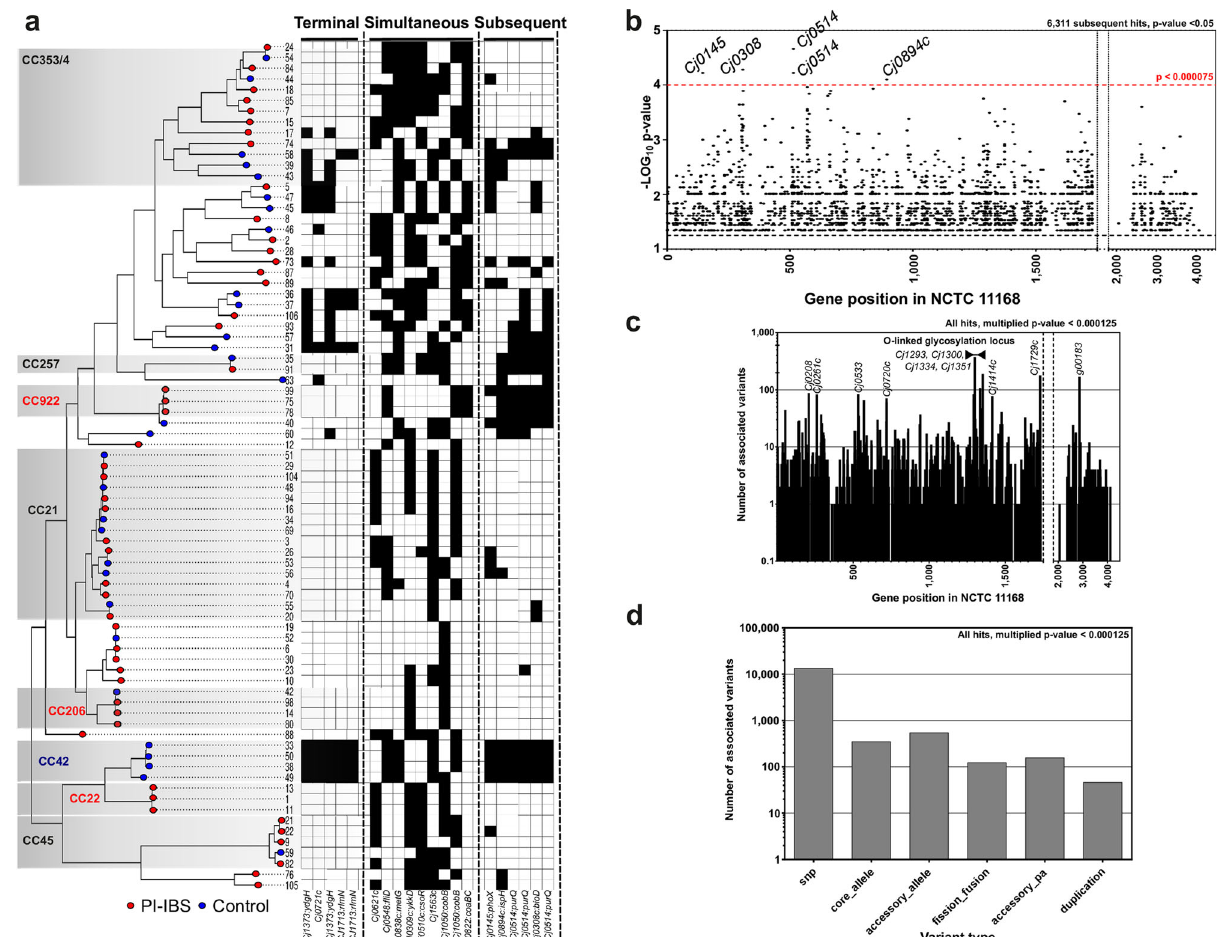
Fig. 2 Genome-wide association of genetic variants with onset of PI-IBS. a ClonalFrame-ML phylogeny of PI-IBS isolates, with recombination masked 114 . Red leaves are isolates from PI-IBS patients and leaves with blue circles are from control patients. Common disease-associated clonal complexes (CCs) are highlighted. Interactive visualization is available on Microreact 101 : https://microreact.org/project/CampyIBS-CF. Matrix shows presence of variants most associated with IBS, which are labeled below (terminal, n = 5; simultaneous, n = 9; subsequent, n = 6). b Pangenome position of associated GWAS results (subsequent p -value < 0.05; n = 6,311; Table S4). Each circle represents a variant mapped to a position in the C. jejuni reference strain NCTC11168 56 or inferred pangenome from this study (Supplementary Data 5). Variants with the strongest association ( p -value < 0.000075; n = 6) from four genes with homologs in NCTC11168 are annotated ( Cj0145:phoX, Cj0308:bioD, Cj0514:purQ , and Cj0894c:ispH ). c Hot spots of associated variants. The number of associated variants per gene in NCTC11168 and the pangenome (any association p -value < 0.05). Genes with more than 100 associated variants are annotated, including four from the O-linked glycosylation locus. d Breakdown of associated variant types (core genome SNPs, core and accessory alleles, gene fi ssion/fusions, accessory gene presence, and gene duplications; any association p -value < 0.05, raw data are available in Supplementary Data